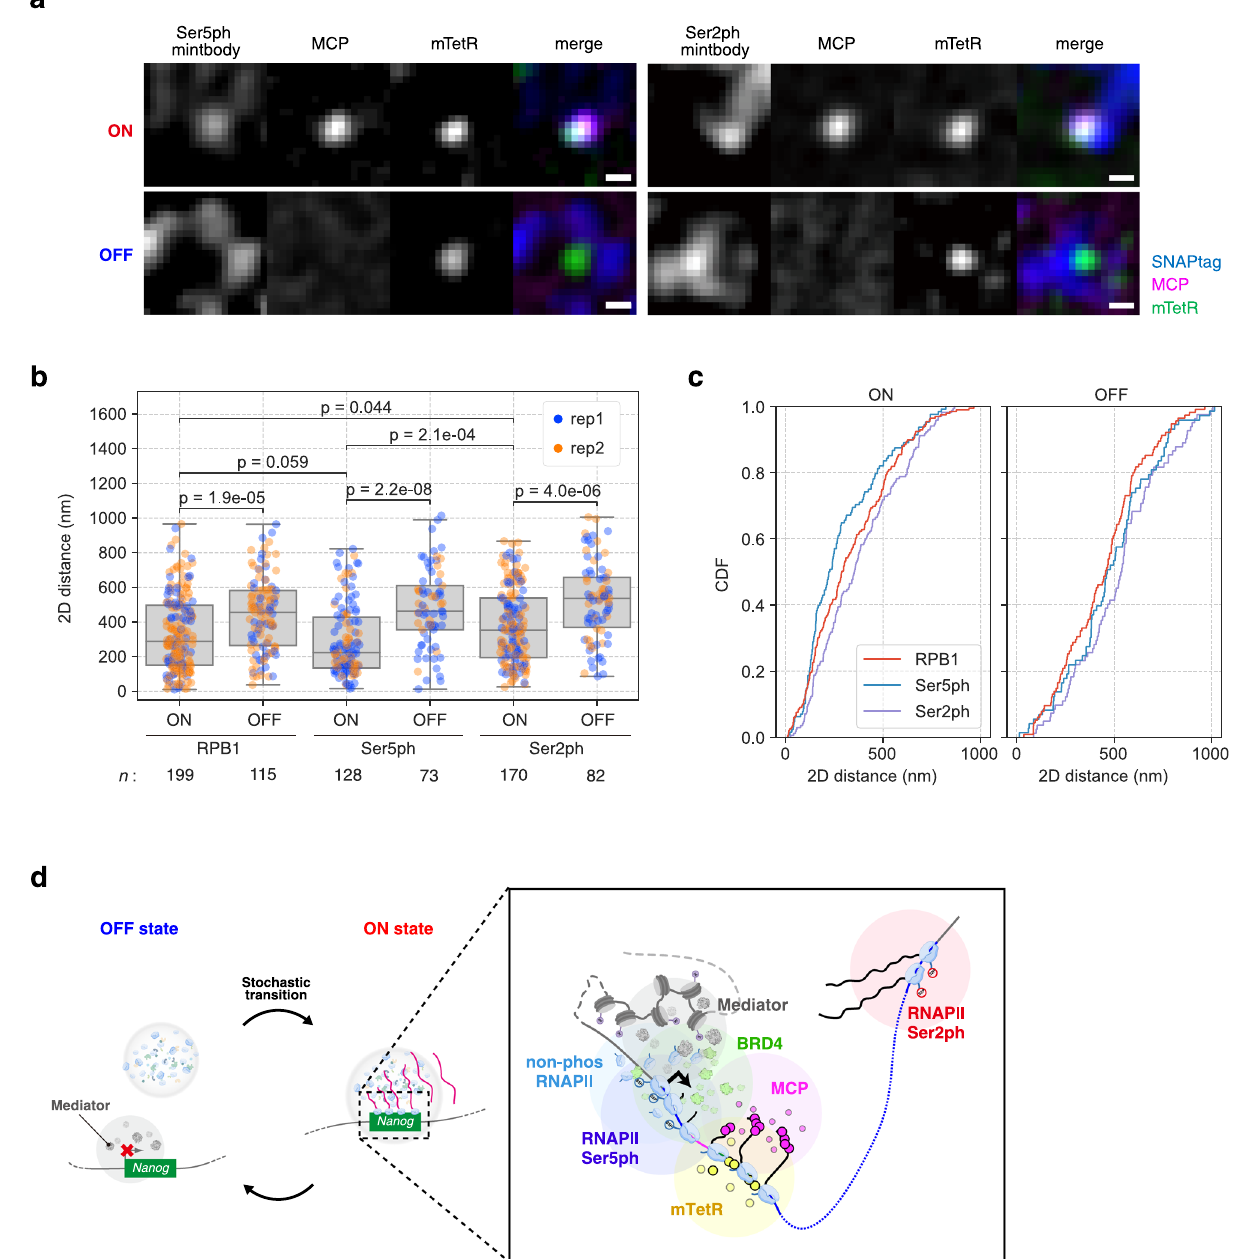
Fig. 7 | RNAPII Ser5ph and Ser2ph form clusters in proximity to Nanog only in theONstateinmouseembryonicstemcells(mESCs).a ImagesofRNAPIISer5ph- and Ser2ph-mintbodies with MCP and mTetR. Cell lines expressing RNAPII Ser5ph andRNAPIISer2phmintbody-SNAPtagwereestablishedusingNSt-GRasaparental cell line. Scale bar, 500nm. b 2D distance between mTetR spots and the nearest SNAPtag foci in the ON and OFF states. Box plots indicate the interquartile range IQR(25 – 75%)withalineatthemedian.Whiskersindicate1.5timestheIQR.Theblue